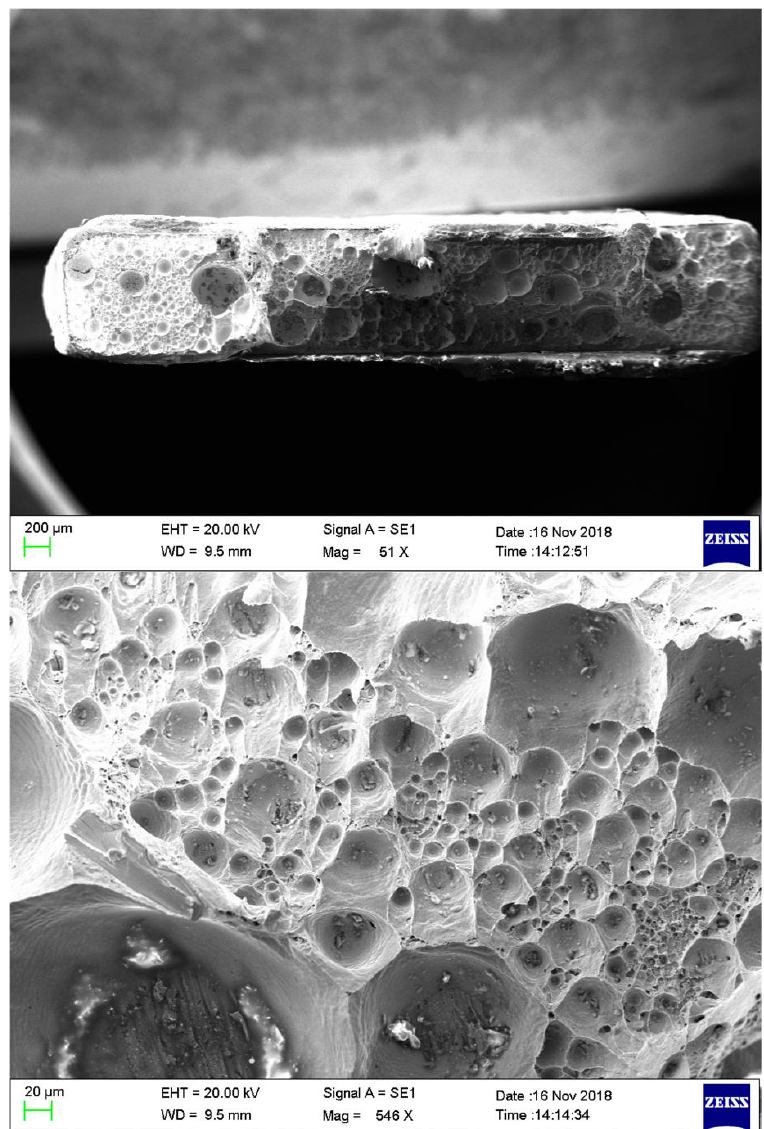
Figure 12. SEM graph of fracture s urface at 25 °C (ductile).